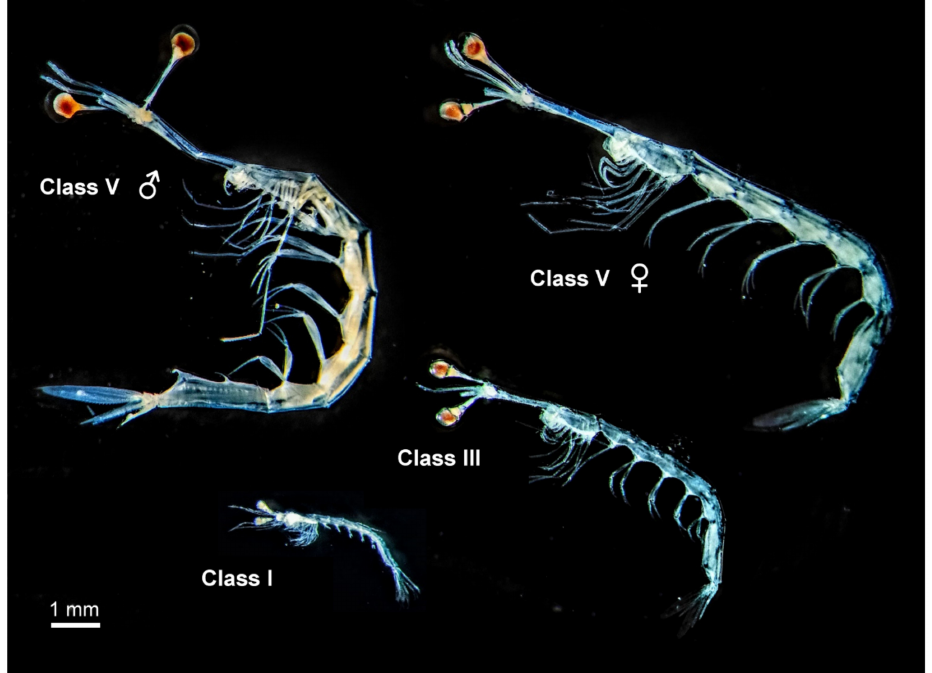
Figure 11. Lucifer typus . Habitus in lateral view from size classes I, III, and